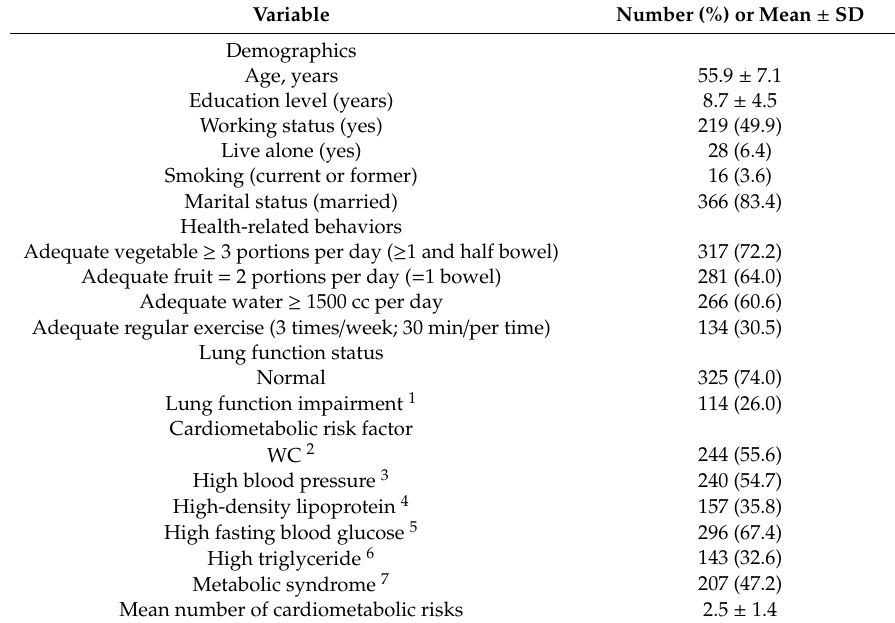
Table 1. Demographic Characteristics of the Middle-Aged Women (N = 439).